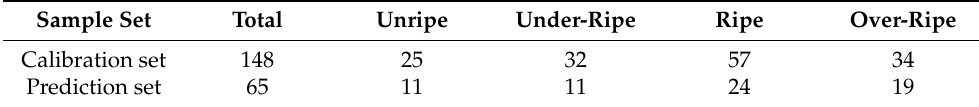
Table 2. Calibration and prediction sets of samples.